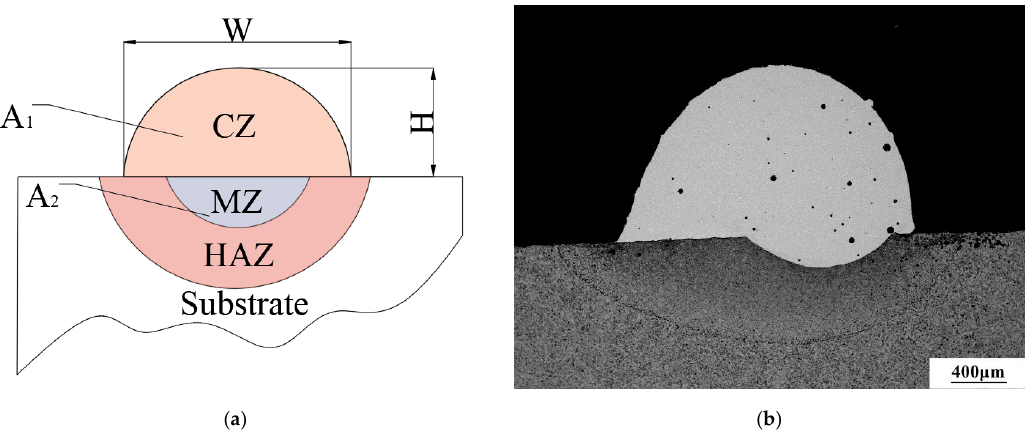
Figure 4. ( a ) Schematic cross-section of the clad. CZ, cladding zone; MZ, melting zone; and HAZ, heat-affected zone. ( b ) Cross-section of the clad under SEM.